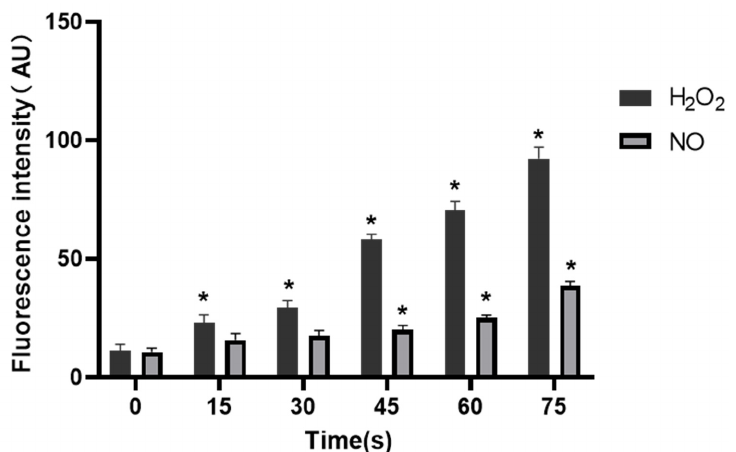
Figure 9. Concentrations of H 2 O 2 and NO in HUVECs, * compared with control group (0 s) p <